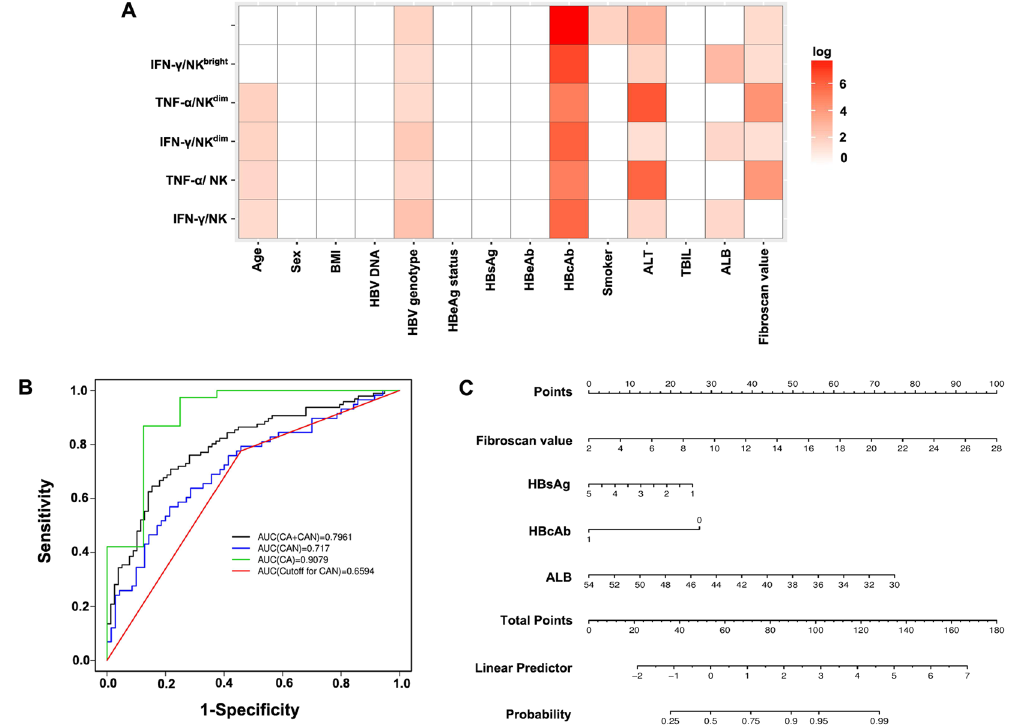
Figure 5. Development of prediction model of NK-cell cytokine function. Correlation of NK cells and their subsets expressing IFN- γ and TNF- α with 14 clinical virology characteristics. p < 0.05 was shown in colour and the depth of red colour represents the degree of significant difference. Pearson correlation was used for continuous clinical variables, and Kruskall Wallis test was used for categorical clinical variables. ( B ) ROC analysis. The ROC curves by these four clinical variable-based classifiers in all CHB patients (CA + CAN), CAN, CA patients, and the ROC curve by the cut-off score based classifier in CAN patients. ( C ) A visual nomogram used to assign the ability of NK-cell cytokine production by summing the scores of the above selected clinical-virological parameters shown on the point scale. The total score projected to the corresponding scale indicates the likelihood of active cytokine immunity. ROC, receiver operator characteristic; AUC, area under the curve.